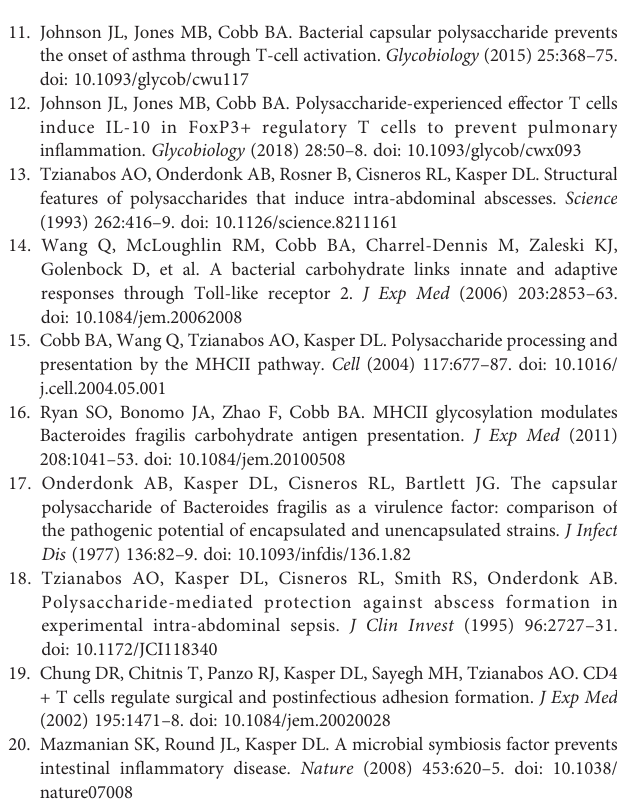
SUPPLEMENTARY FIGURE 1 | Gene enrichment and ontology analysis in response to PSA exposure. Gene ontology was conducted on differentially expressed genes (FDR > 0.05 and log2CPM > 0). (A) Heat map of top 500 differentially expressed (DE) genes on D7 compared to D0. (B) Multidimensional scaling plot of all DE genes, showing scatter of D7 and D0 samples (each dot is a replicate sample). Top 20 signi fi cantly increased (red) or decreased (blue) gene ontology terms by (C) Biological process (D) Molecular Function and E) Cellular component (values shown are − log 10 of p value). SUPPLEMENTARY FIGURE 2 | FoxP3 expression in PSA-stimulated populations of CD4 + T cells. CD4 + T cells and MHCII + APCs were co-cultured with PSA as before for 3 or 7 days with and without varied amounts of anti-IL-4 neutralizing antibody or 5 m g of an isotype control. The (A) FoxP3 geometric mean fl uorescence intensity (i.e., amount of FoxP3 protein) and the (B) percent of T cells expressing FoxP3 did not change signi fi cantly. SUPPLEMENTARY FIGURE 3 | Unchanged cytokines and chemokines in PSA- exposed cell culture. Luminex and RNAseq values for cytokines and chemokines that are not impacted by PSA stimulation. SUPPLEMENTARY TABLE 1 | List of top 500 DEGs with p values. Complete list of the top 500 differentially expressed genes in CD4 + cells stimulated for 7 days with PSA. SUPPLEMENTARY TABLE 2 | List of IRGs with p values. List of all interferon- responsive genes and their associated p values from CD4 + cells stimulated for 7 days with PSA. SUPPLEMENTARY TABLE 3 | List of all LegendScreen markers and their GeoMFI values. Complete list of all LegendScreen antibody markers and their associated geometric MFI